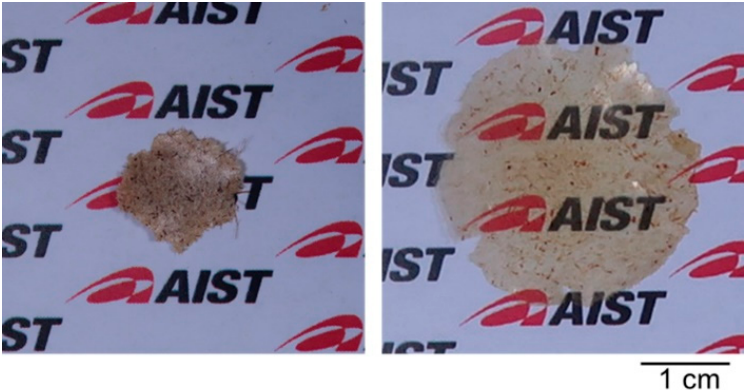
Figure 10. Photographs of a mass obtained by pressing degreased wood powder ( left , entry 0) and a translucent film obtained by pressing wood powder benzylated at a low temperature using an [( n -Bu) 4 P]OH solution ( right , entry 6).